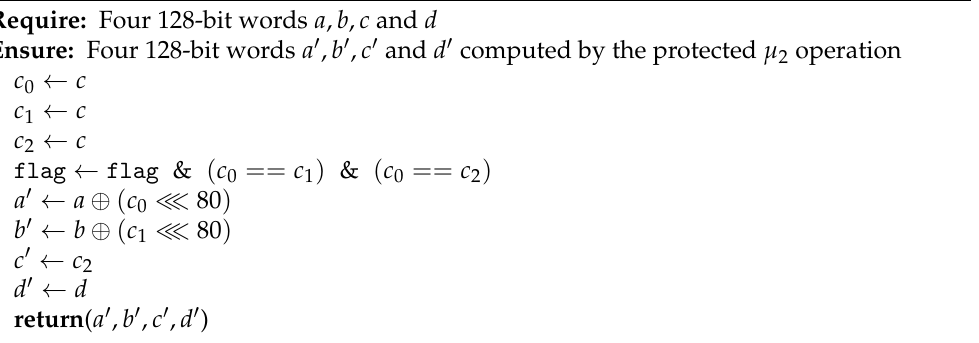
Algorithm 2 Protected µ 2 operation of the FRIET-P